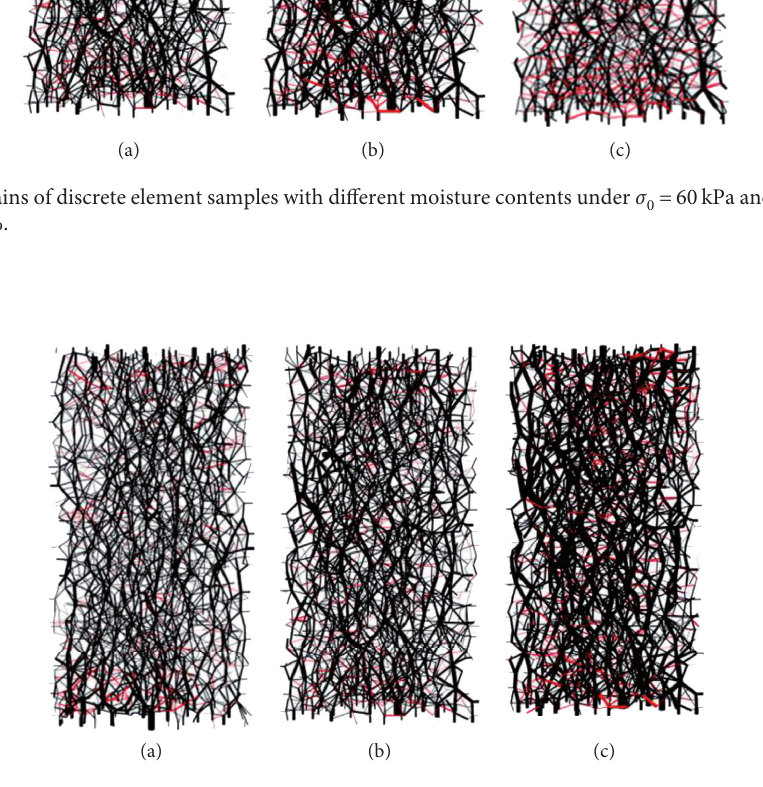
� 60kPa. (a) f � 0.5Hz. 0